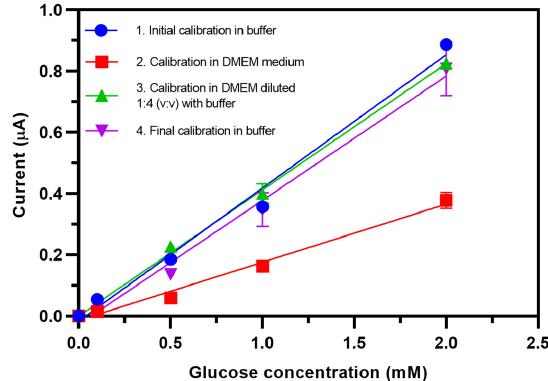
Figure 8. Calibration curve of a single TEMPO-CNC glucose sensor in the range from 0.1 to 2.0 mM glucose in the following order: (1) Phosphate bu ff er, (2) DMEM medium, (3) diluted DMEM medium (1:4 [ v : v ] with phosphate bu ff er), and (4) phosphate bu ff er. DMEM refers to DMEM medium